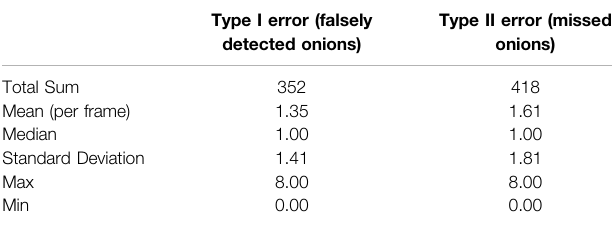
TABLE 2 | Summary of Type I and Type II error distribution for the Watershed Method.